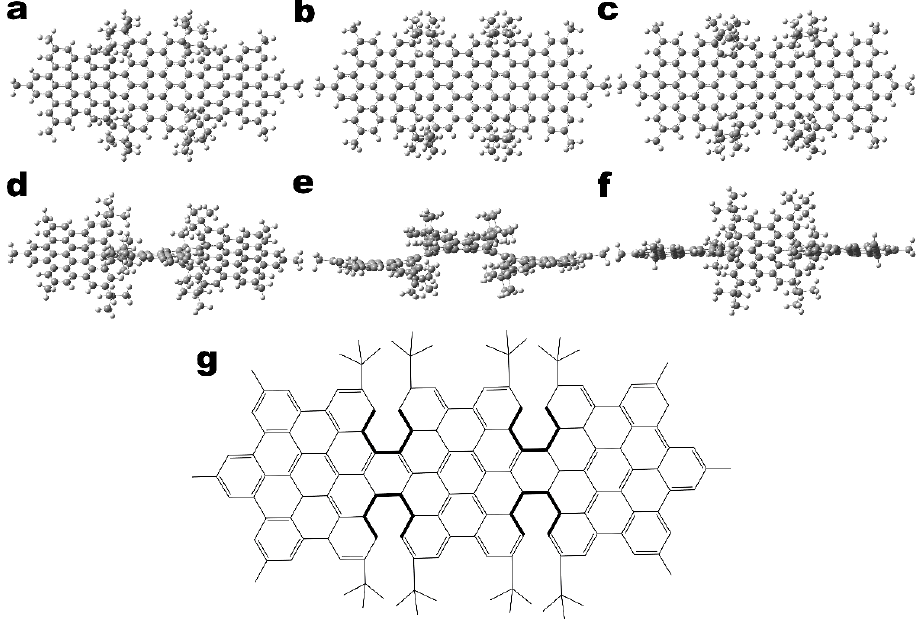
Figure 1. The molecular structure of the three isomers. ( a ) The molecular structure diagram of the asymmetric isomer MMMM, PPMM and PMPM ( a – c ), and their side view ( d – f ) and chemical structure ( g ).